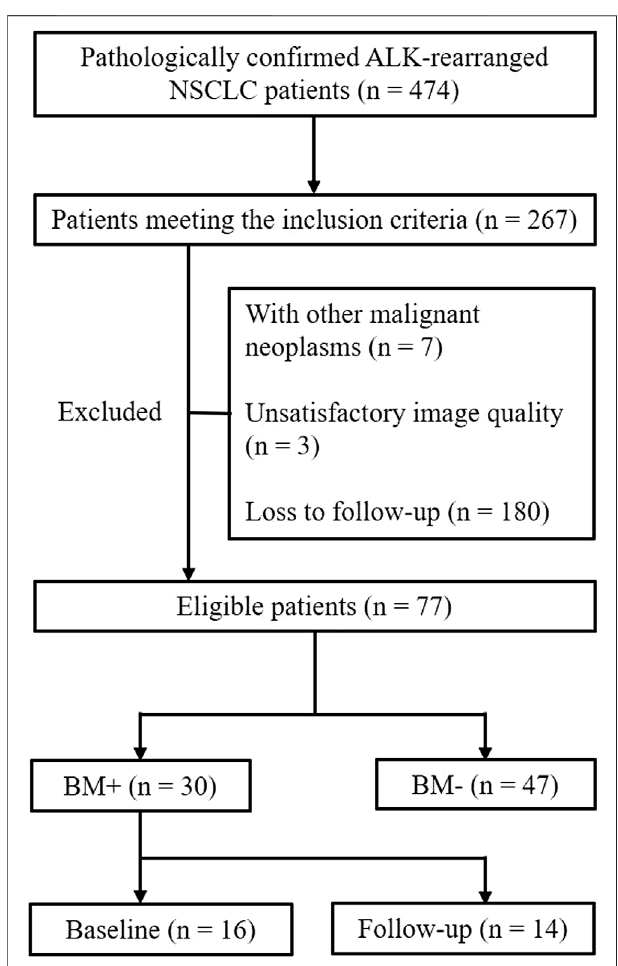
FIGURE 1 | Flowchart of the patient selection